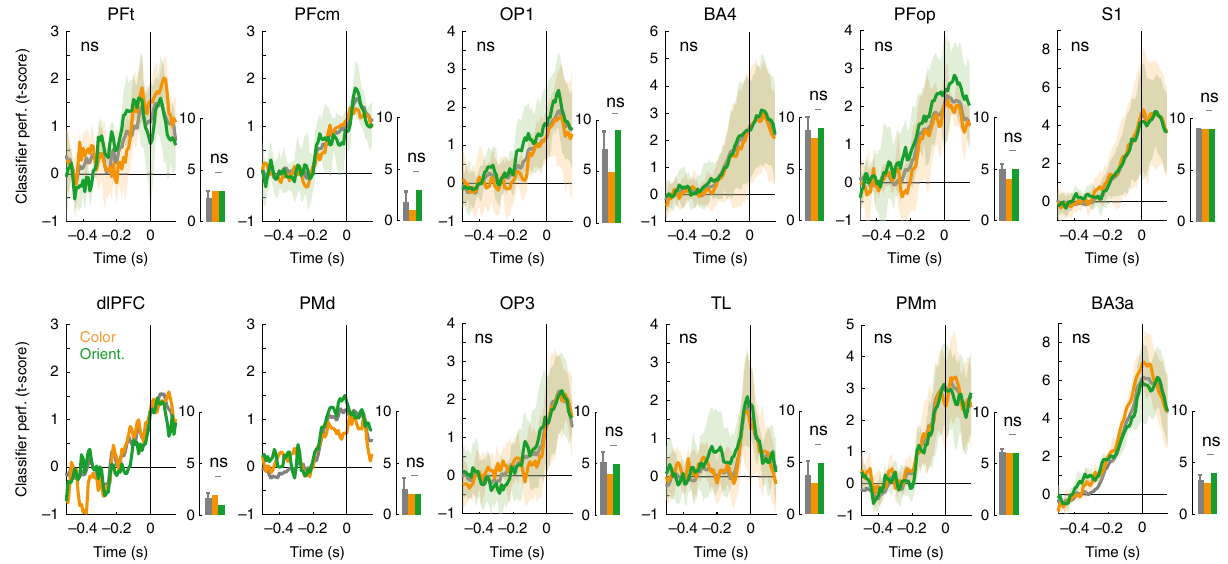
Fig. 3 Decisions for color and orientation rules invoke similar responses in the same brain regions. The left panels show the average classi fi er performance traces (± standard deviation, numbers of data points included are given in the right panels) for classi fi ers trained on only color rule trials (orange), only orientation rule trials (green), and the average of ten subsampled trial sets that included both color and orientation rules, and match the trial count of one rule (gray). All brain regions that showed signi fi cant left/right decoding based on all trials are included here. For all regions with three or more decoding leads for both the color and orientation only classi fi ers, a cluster-based permutation test was performed to compare decoding performance of color and orientation over time. None of the clusters survived FDR correction. The right panels show the number of leads that show signi fi cant decoding for each of the classi fi ers. For the subsampled classi fi er bars show the mean, and error bars indicate the standard deviation across ten repetitions (raw data can be found in Supplementary Table 5). Horizontal bars indicate a one-sided Wilcoxon rank test of the difference between the number of leads for color and orientation rule compared to pairs of randomly subsampled classi fi ers ( α = 0.05; FDR corrected); ns is not signi fi cant. The total number of leads per brain area can be found in Supplementary Fig.